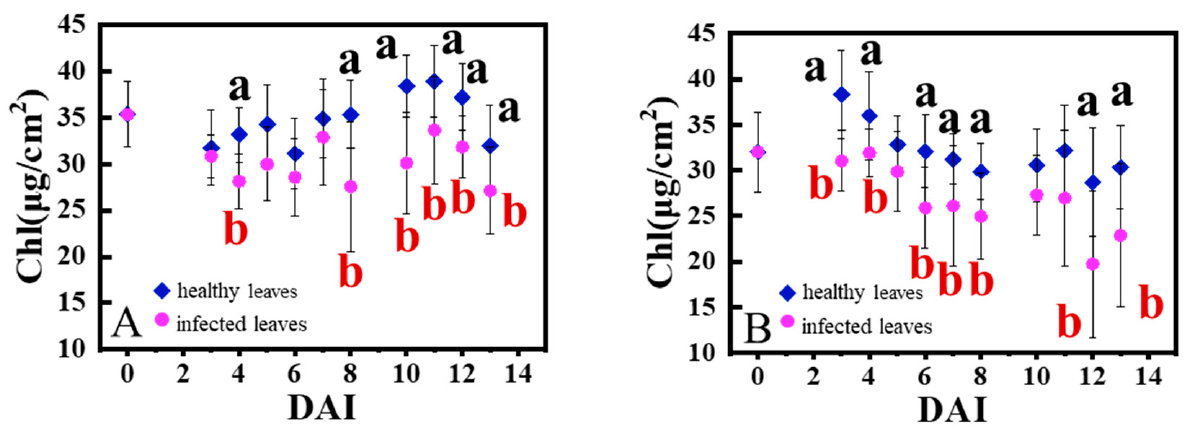
Figure 10. Changes and comparison of chlorophyll content between healthy leaves and diseased leaves infected at jointing stage ( A ) and booting stage ( B ) on the day after inoculation (DAI). Note: ab represents a difference that is significant ( p < 0.05).